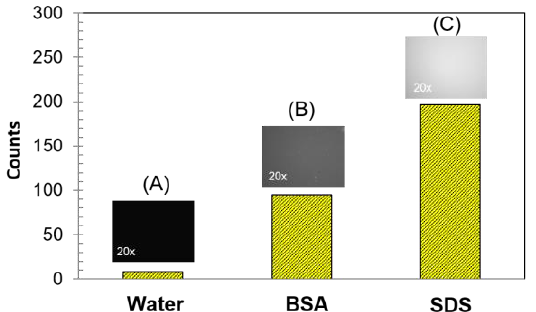
Figure 4. Fluorescence intensity of ADP(CA) 2 in: water ( A ); 1% BSA solution ( B ); and 1‰ SDS solution ( C ). Excitation filter: 632/22 band-pass filter; Emission filter: 711/25 band-pass filter; Light source energy: 25%; Objective: 20×; Exposure time: 3 s.